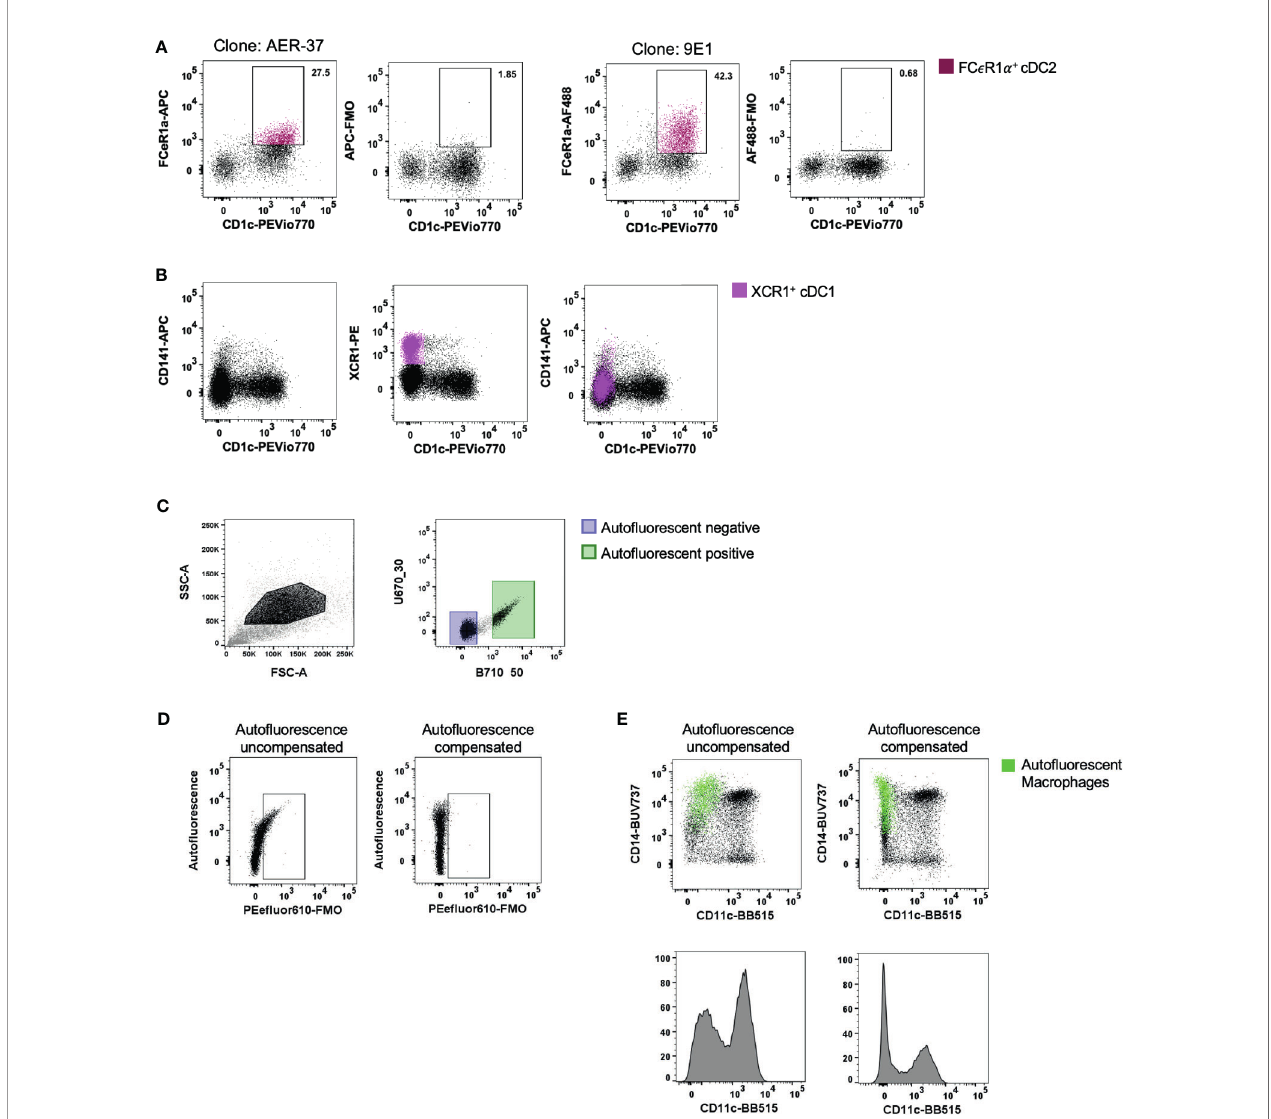
FIGURE 3 | Optimisation of staining and acquisition parameters for fl ow cytometry. Intestinal mononuclear phagocytes were isolated as per Figure 1 . (A, B) Cells were stained to isolate HLA-DR + CD45 + CD3 - CD19 - CD11c + DCs. (A) In the same donor, FC e R1 a expression was compared between clones AER-37 and 9E1 for optimal expression, with corresponding Fluorescence Minus One (FMO) control. (B) Expression of de fi ning conventional DC (cDC) 1 markers XCR1 and CD141 were compared in the same donor for correlation in intestinal tissue. (C) Representative plot of unstained intestinal cells, gated on events with higher side scatter. Auto fl uorescent negative and positive cells were gated and applied to un unused detector channel in FlowJo V10.7.1 to create the auto fl uorescent-corrected compensation matrix. (D) Representative plots for auto fl uorescent correction, showing correction of fl uorescent signal for PEe fl uor610. (E) Representative plots of live HLA-DR + CD45 + CD3 - CD19 - mononuclear phagocytes, comparing the CD11c BB515 signal with and without correction of auto fl uorescent signal. Auto fl uorescent macrophages overlaid, gated for CD14+ and auto fl